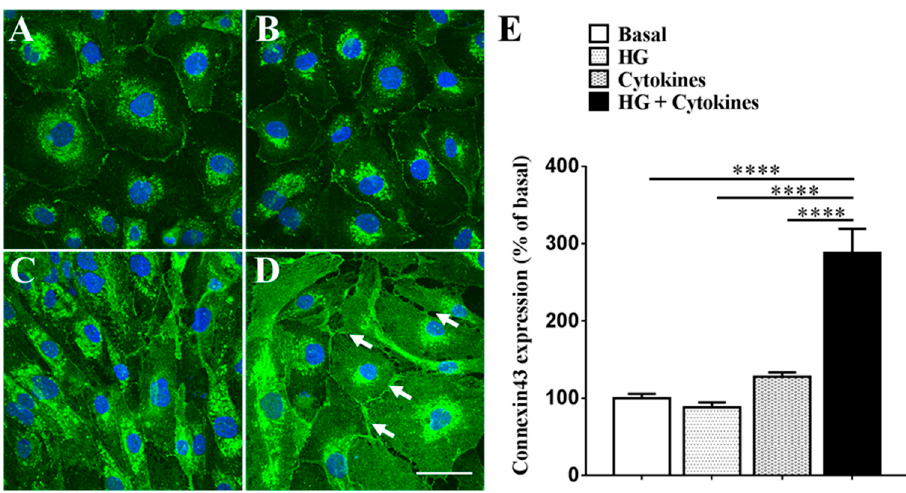
Figure 1. Effect of HG (high glucose) and pro-inflammatory cytokines on connexin43 expression in hRMECs. Immunohistochemical data showing connexin43 expression in ( A ) normal medium; ( B ) HG (25 mM); ( C ) pro-inflammatory cytokines (IL-1 β and TNF- α 10 ng/mL each); and ( D ) a combination of HG and pro-inflammatory cytokines inducing a change in cell morphology with signs of cell swelling, possibly owing to hemichannel opening (indicated by white arrows); ( E ) Quantification of connexin43 expression relative to basal levels. Neither HG ( p = 0.9569) nor pro-inflammatory cytokines ( p = 0.6490) significantly increased connexin43 expression. However, co-application of HG and cytokines increased connexin43 levels relative to basal, HG, and cytokines alone ( p < 0.0001 for all). Scale bar = 5 nm. Data presented as mean + SEM. Statistical comparisons were carried out using one-way ANOVA with Tukey’s multiple comparisons test; n = 6; t = 24 h; **** p ≤ 0.0001.